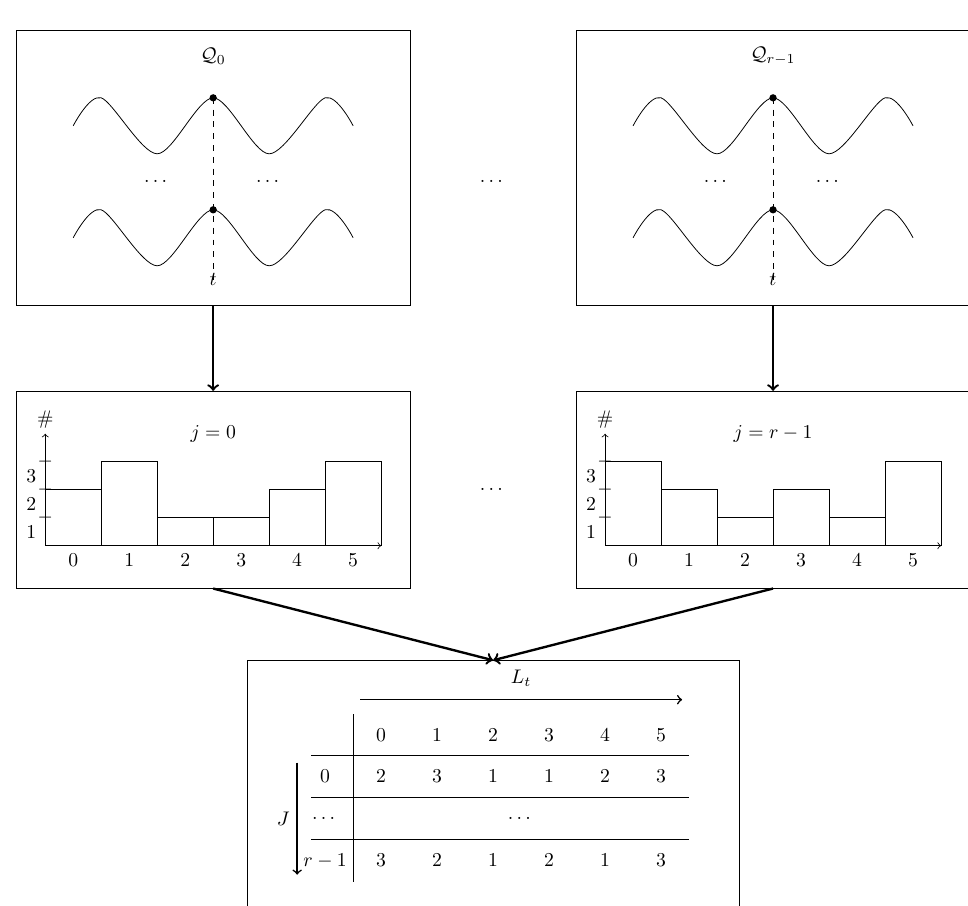
Figure 2: Our proposed leakage detection methodology based on Pearson’s χ 2